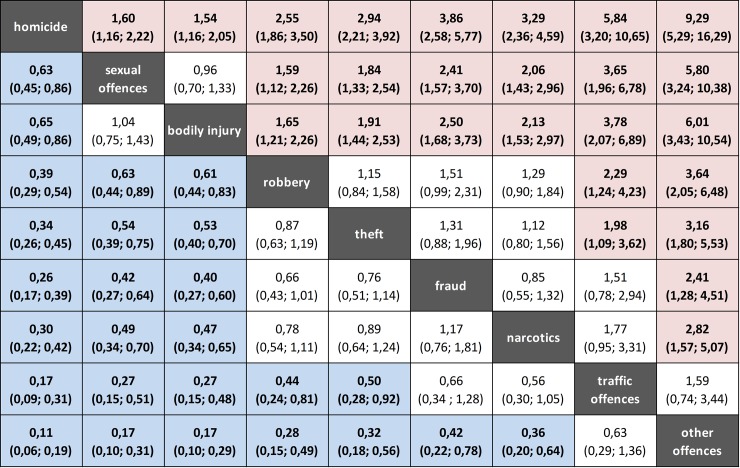
Head-to-head comparison of suicide risks (SR) of offence-groups.Entries in each cell represent the suicide risk ratio of the row-defining offence-groups compared to the column-defining offence-groups, given as Odd's Ratios and 95% confidence intervals. For example the suicide risk of prisoners convicted for homicide is increased by factor 1,60 compared with prisoners convicted for sexual offences; vice versa, prisoners convicted for sexual offences show a suicide risk diminished by factor 0.63 compared with prisoners convicted for homicide. Cells representing significantly increased (decreased) suicide risk were marked with red (blue) colour.